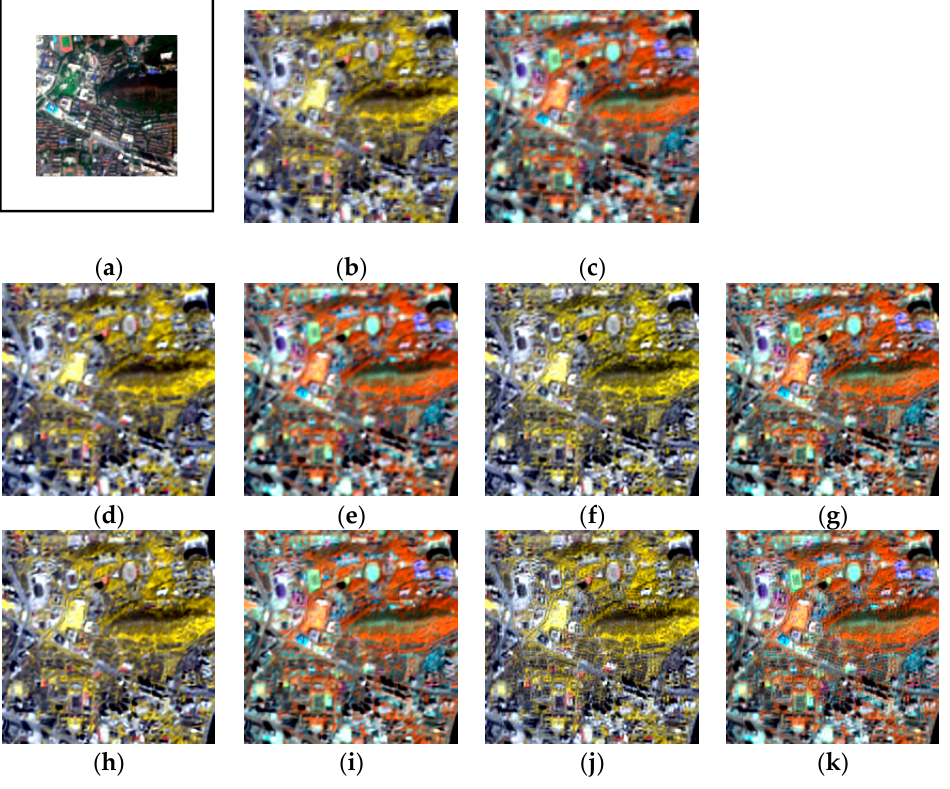
Figure 13. Visual performance before and after fusion. ( a ) The narrow-swath-width HR data. ( b ) False-color synthesis of band 5, band 6, and band 7 before fusion. ( c ) False-color synthesis of band 8a, band 11, and band 12 before fusion. ( d , e ) The results of bicubic. ( f , g ) The results of SRCNN. ( h , i ) The results of VDSR. ( j,k ) The results of WSSRN.